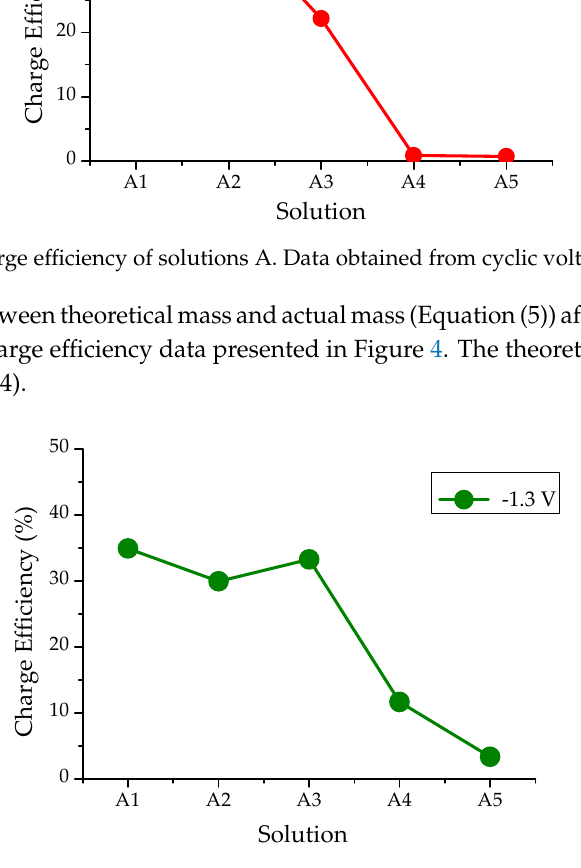
Figure 4. Charge e ffi ciency of solutions A. Data obtained from post electrodeposition mass Figure 4. Charge efficiency of solutions A. Data obtained from post electrodeposition mass gain.